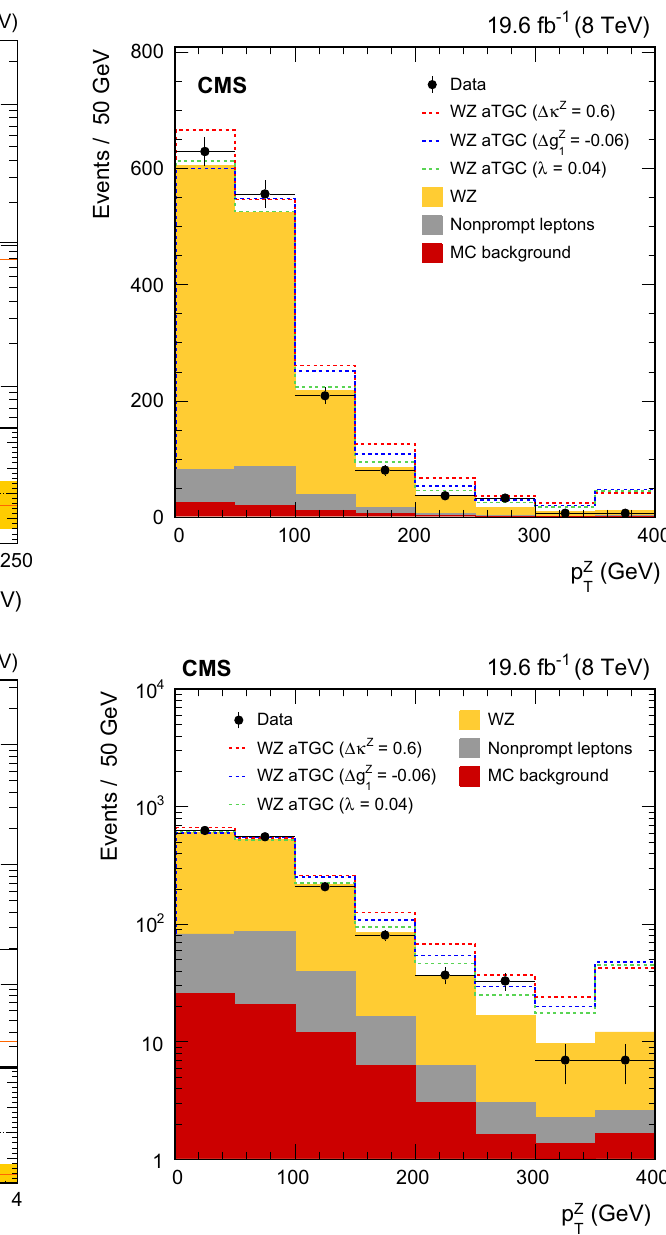
√ Fig. 6 Differential WZ cross section at s = 8TeV as a function of: ( top ) the leading jet transverse momentum; ( bottom ) the number of accompanying jets. The measurements are compared with MadGraph predictions. The MadGraph prediction is rescaled to the total NLO cross section as predicted by mcfm . The error bands in the ratio plots indicate the relative errors on the data in each bin and contain both statistical and systematic uncertainties m 2 W κ γ = 1 + ( c + c , ) W B 2 (cid:18) 2